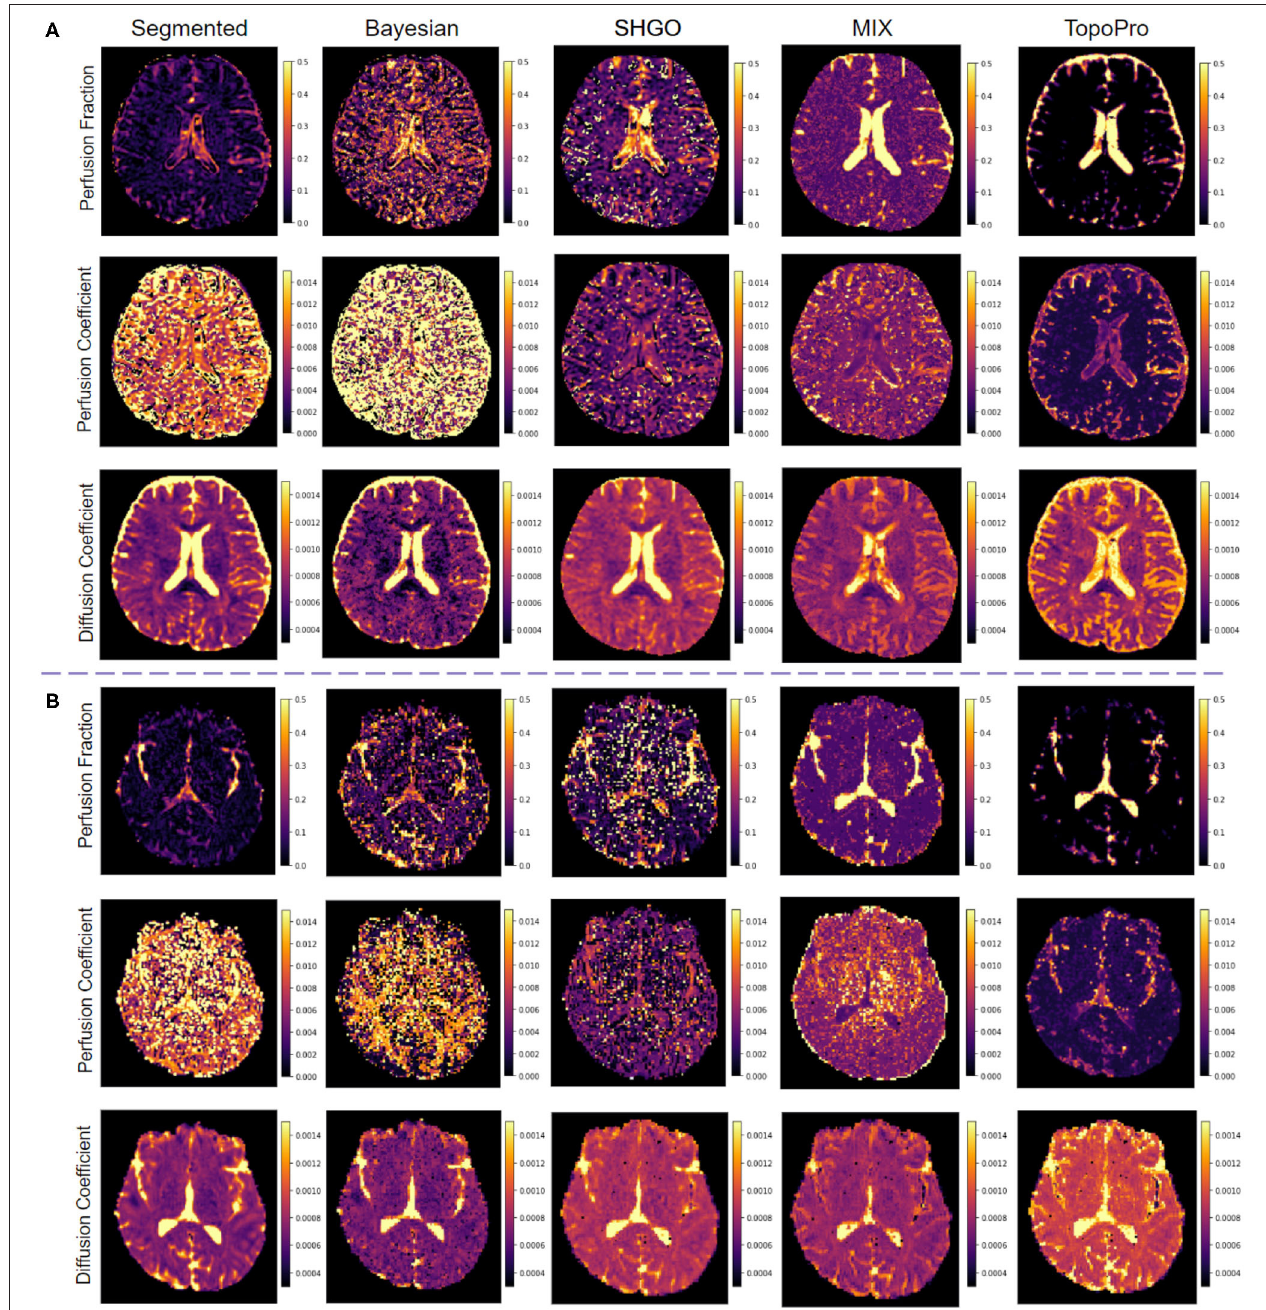
FIGURE 6 | Comparisons of TopoPro on two different real human brain datasets vs. 4 different methods: (A) DWI dataset with dimensions: 256 × 256 × 54 × 21 - slice 33 and (B) DWI dataset with dimensions: 140 × 140 × 84 × 49 - slice 42. Notice how TopoPro provides improved estimates of the different parameters of the IVIM model in both data. The results are compared against methods: Segmented, Bayesian, SHGO, and